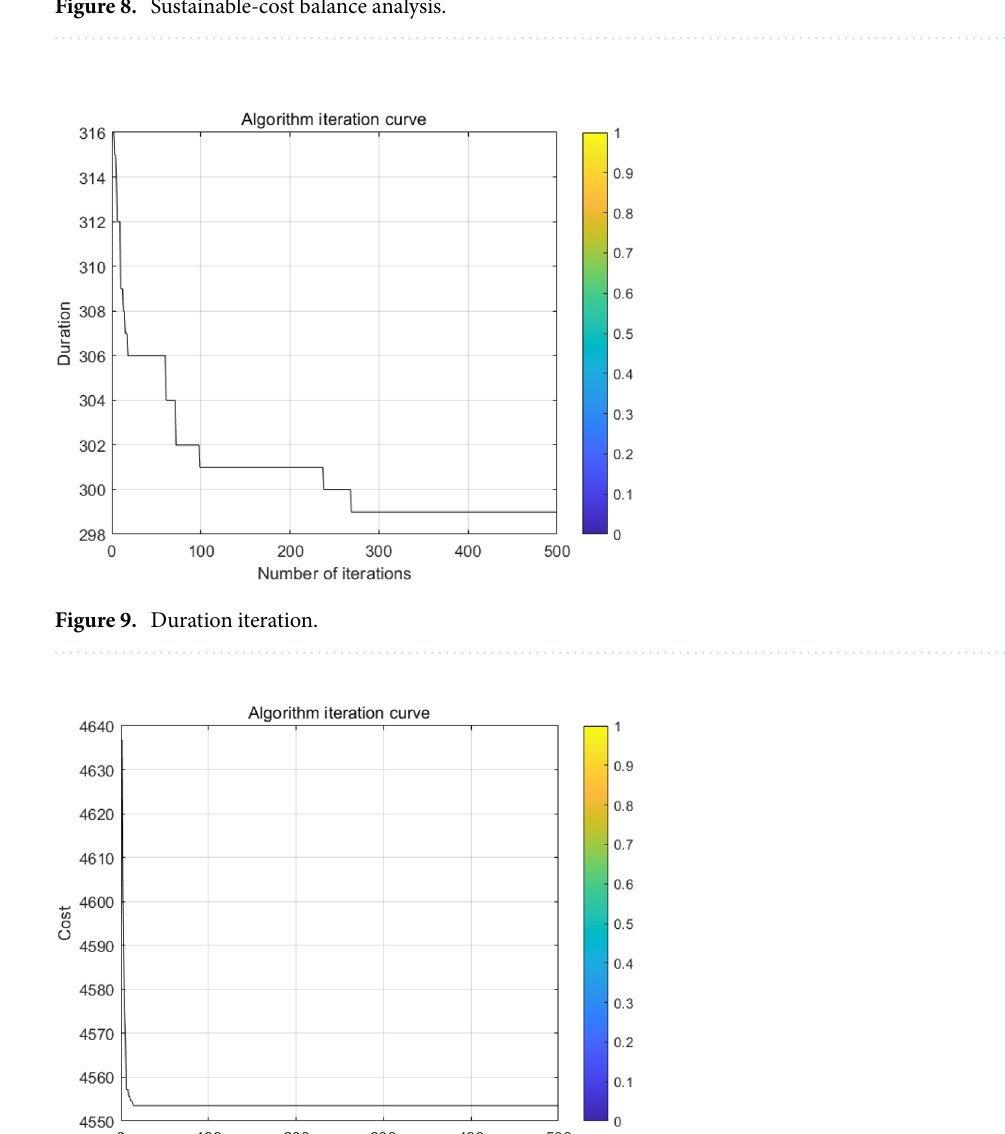
Figure 8. Sustainable-cost balance analysis.